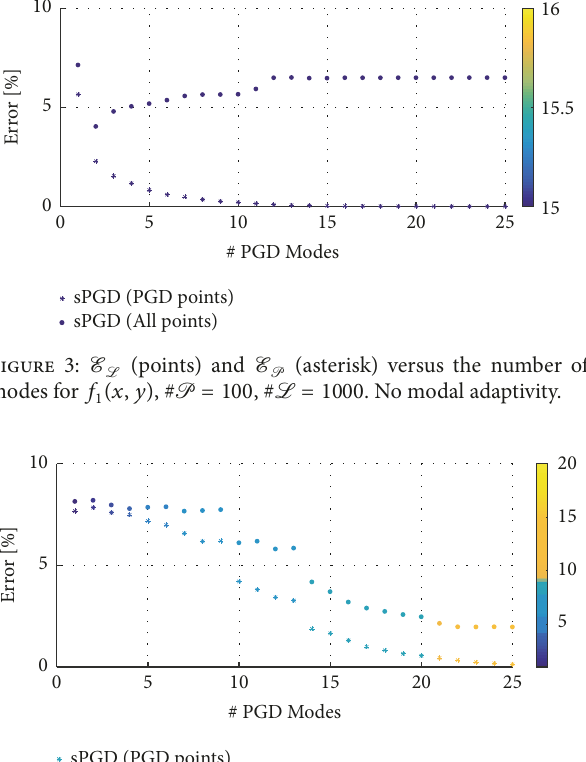
sPGD (PGD points) sPGD (All points) Figure 4: E L (points) and E P (asterisk) versus the number of modes for 𝑓 1 (𝑥,𝑦) , # P = 100 , # L = 1000 . Modal adaptivity based on the residual, 𝜖 𝑟 =